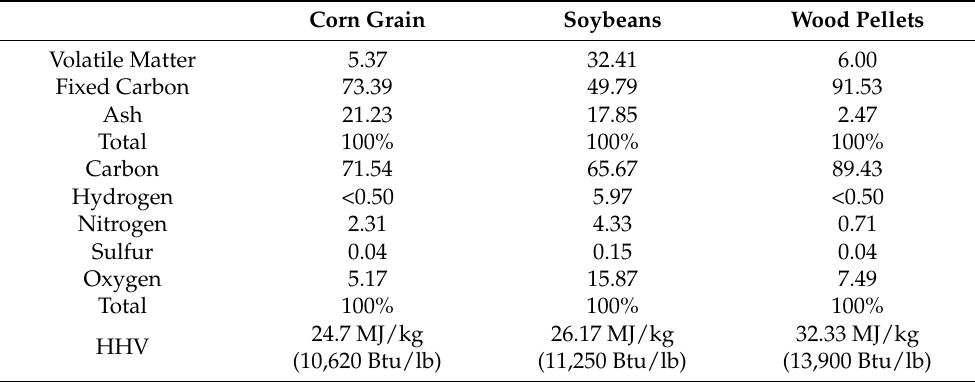
Table 3. Proximate and ultimate analysis of biochar.